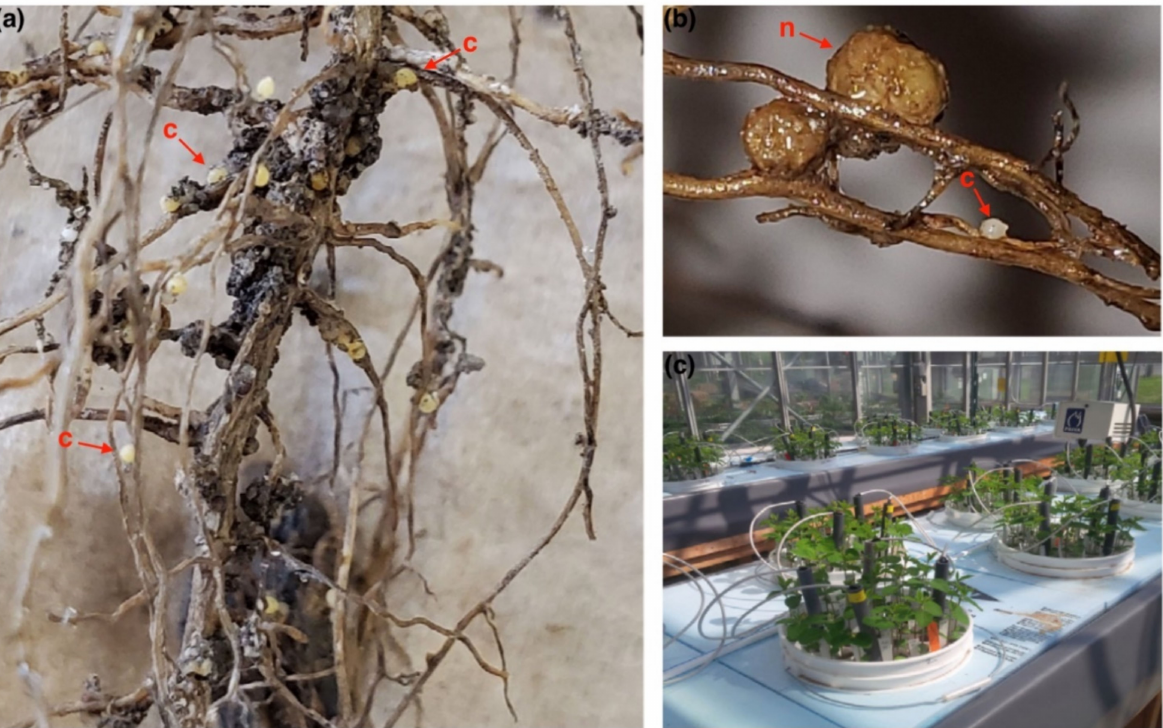
Figure 1. Soybean cyst nematode Heterodera glycines Ichinohe (SCN) infection on soybean roots and phenotyping facility. ( a ) SCN females shown on soybean roots; ( b ) A comparison between a nodule = n within the soybean root vs. a female nematode = c, highlighted with red arrows; ( c ) An SCN phenotyping facility at Agriculture and Agri-Food Canada, Saint-Jean-sur-Richelieu Research and Development